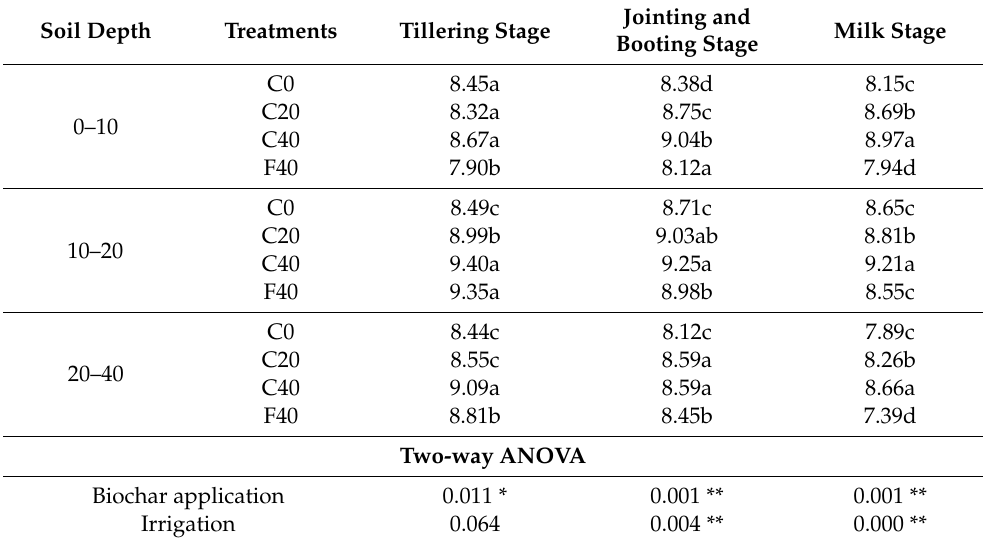
Table 4. Characteristics of soil catalase (CAT) activity under di ff erent water-carbon regulation scenarios in paddy fields (mg /